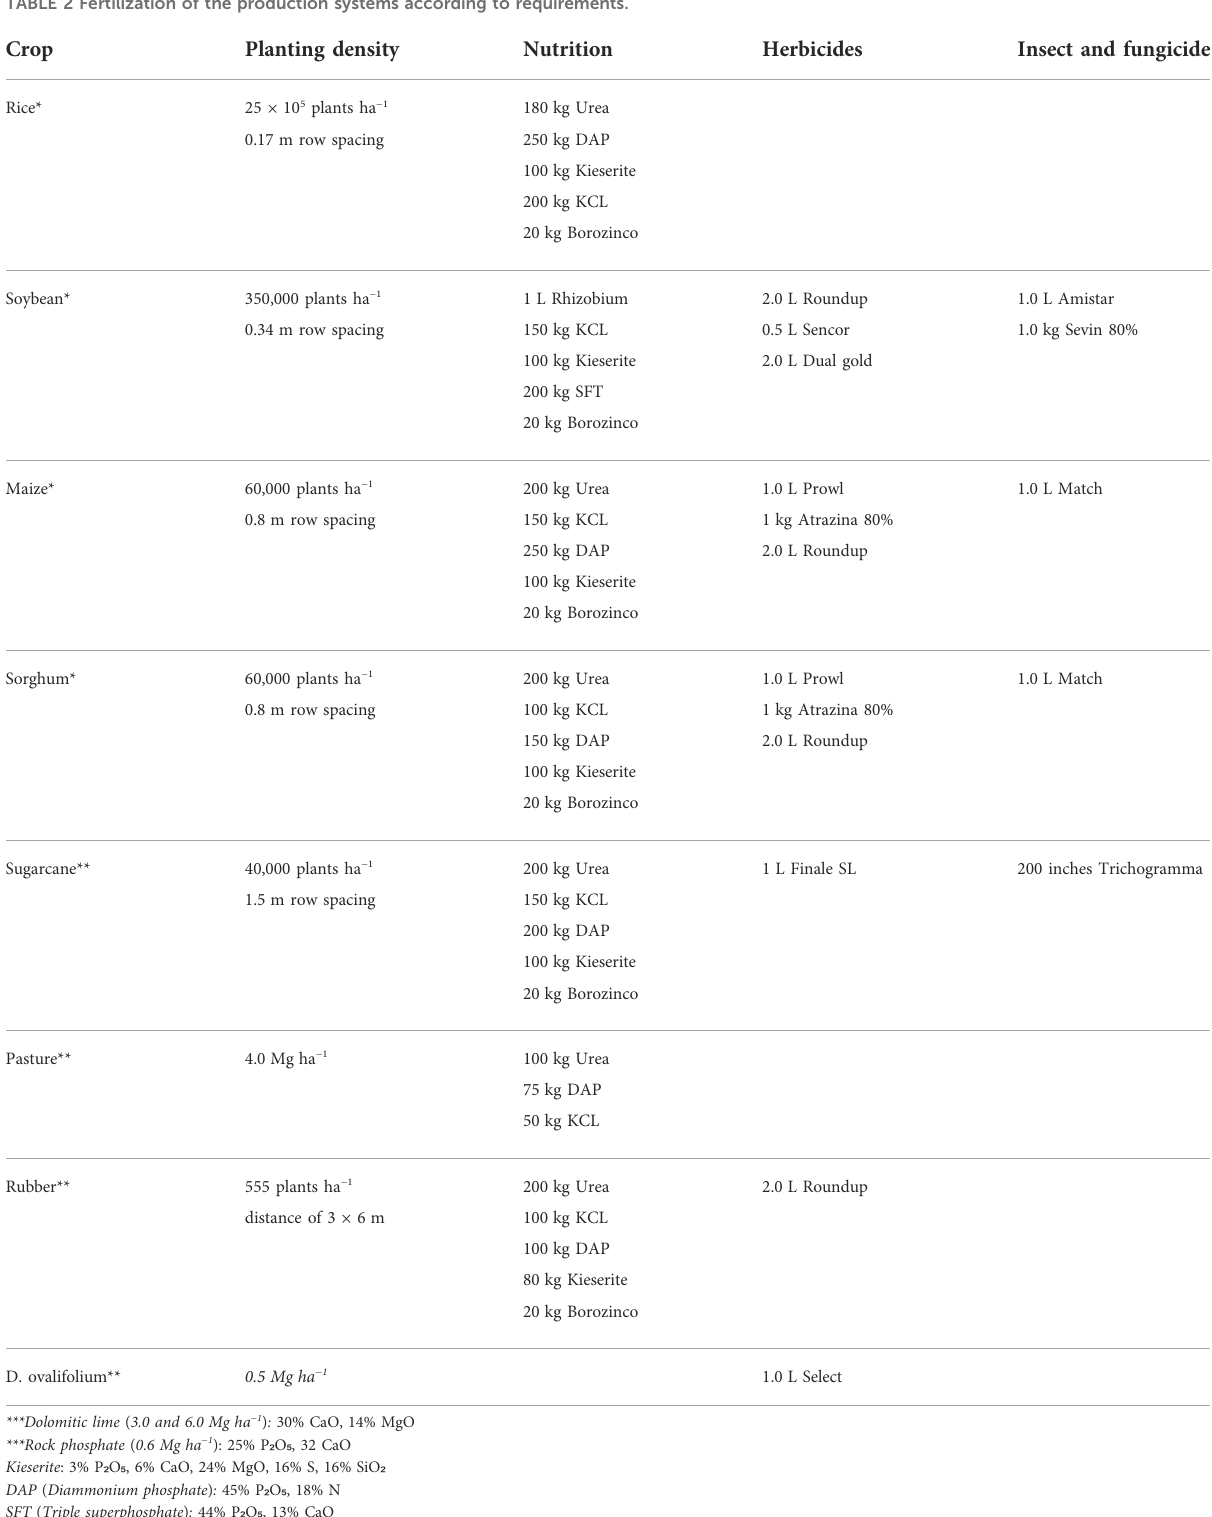
TABLE 2 Fertilization of the production systems according to